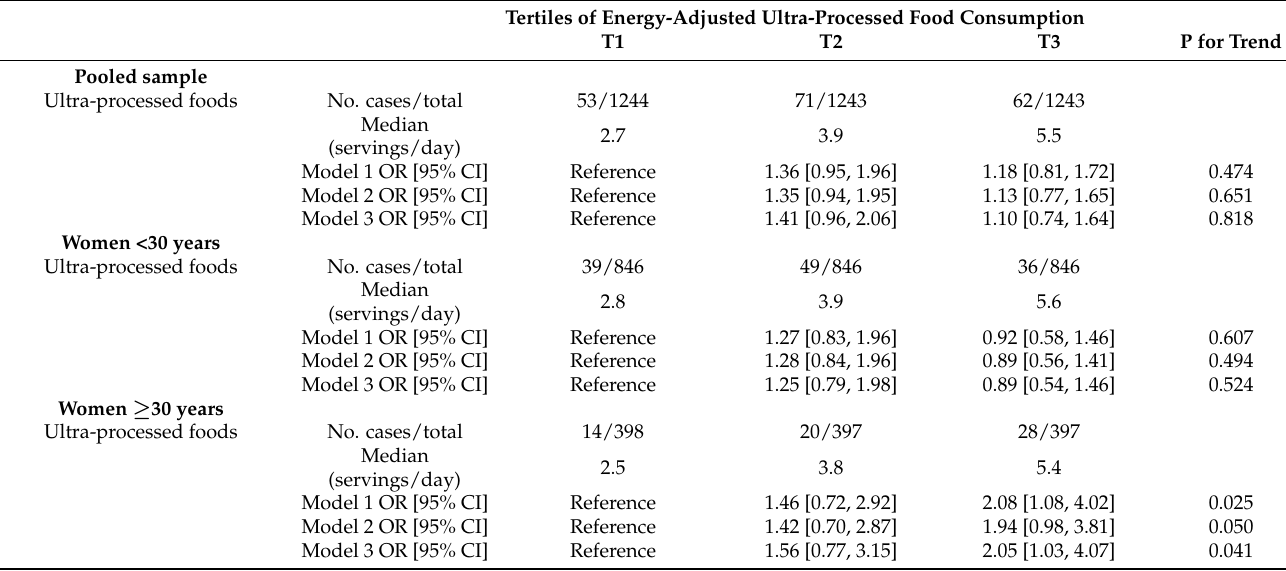
Table 3. Association of pre-gestational ultra-processed food consumption and risk of gestational diabetes in the pooled sample and stratified by age. Tertiles of Energy-Adjusted Ultra-Processed Food Consumption T1 T2